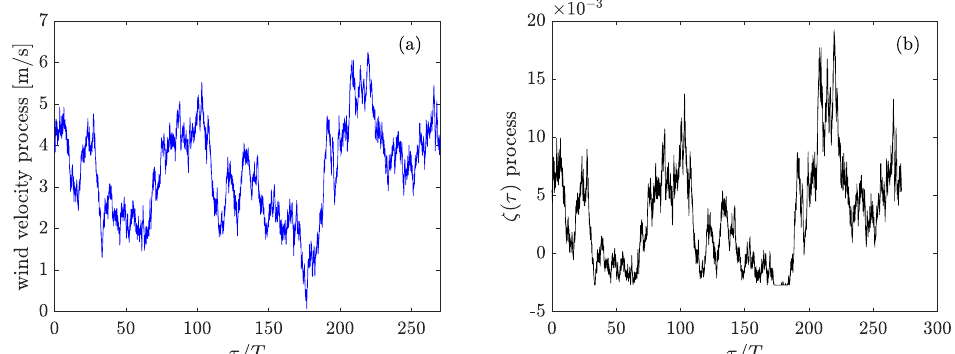
Figure 17. (a) Wind velocity process and (b) corresponding time dependent random forcing process ζ ( τ ) for the lab parameters V m = 4 m/s, σ v = 2 m/s, carrier wave frequency ω = 10.68 rad/s and wave number k = 11.63.